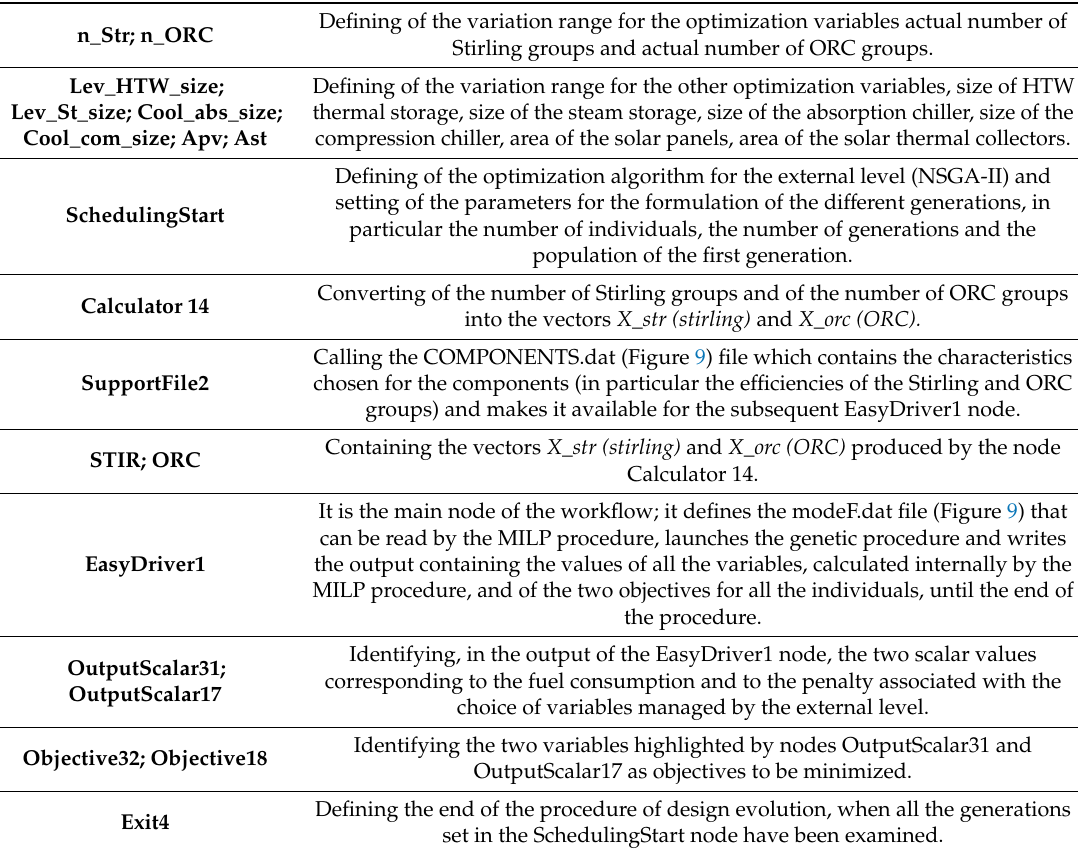
Figure 10. Work flow of the optimization algorithm in the modeFRONTIER ® environment. Table 2. Functions of the nodes in the graphical workflow in Figure